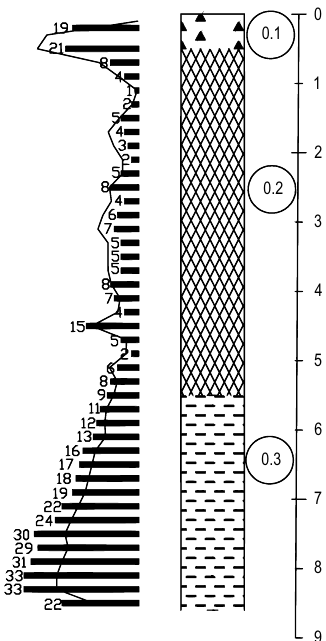
Fig. 1. Typical geological profile with N soil with sand; 0.2 – Backfill soft to stiff consistency;